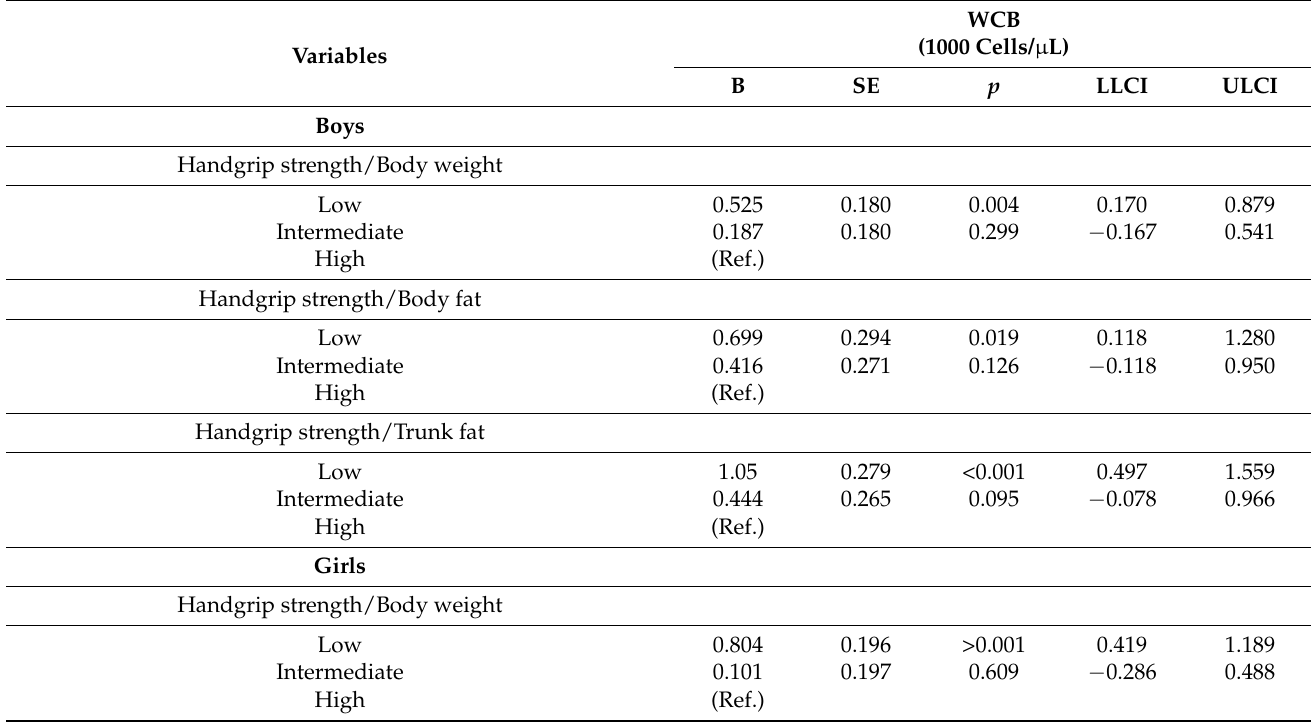
Table 2. Association between white blood cells count and normalized handgrip strength parameters in US